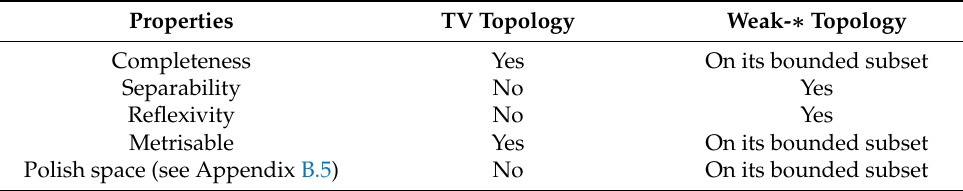
Table A2. Algebraic properties of M ( X ) for its two main